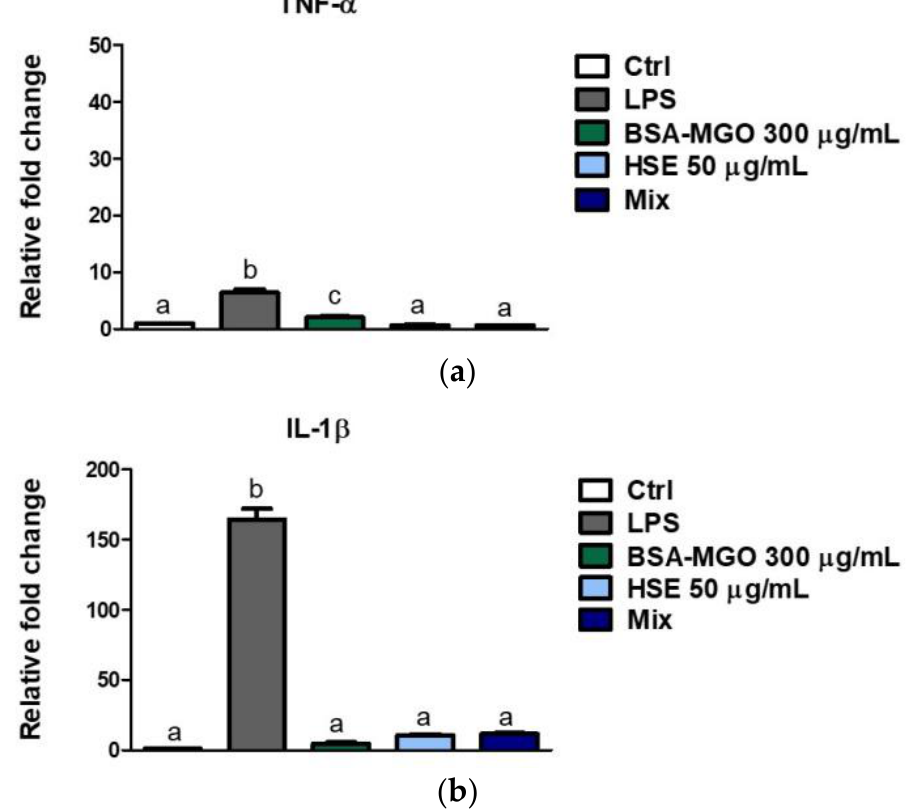
Figure 7. Expression of TNF- α and IL-1 β . THP-1 macrophages (M0) were treated with BSA-MGO, HSE or a combination (MIX). Expression of ( a ) TNF- α and ( b ) IL-1 β genes were quantified using qPCR after 24 h. Data were normalized to untreated control cells. All data represent the means ± SD of relative mRNA expression of two independent experiments. The analysis of variance was carried out using one- way ANOVA followed by Tukey’s multiple comparison test: letters denote significant differences among samples. p < 0.01 BSA – MGO vs. MIX for TNF- α; p = ns BSA – MGO vs. MIX for IL- 1 β).